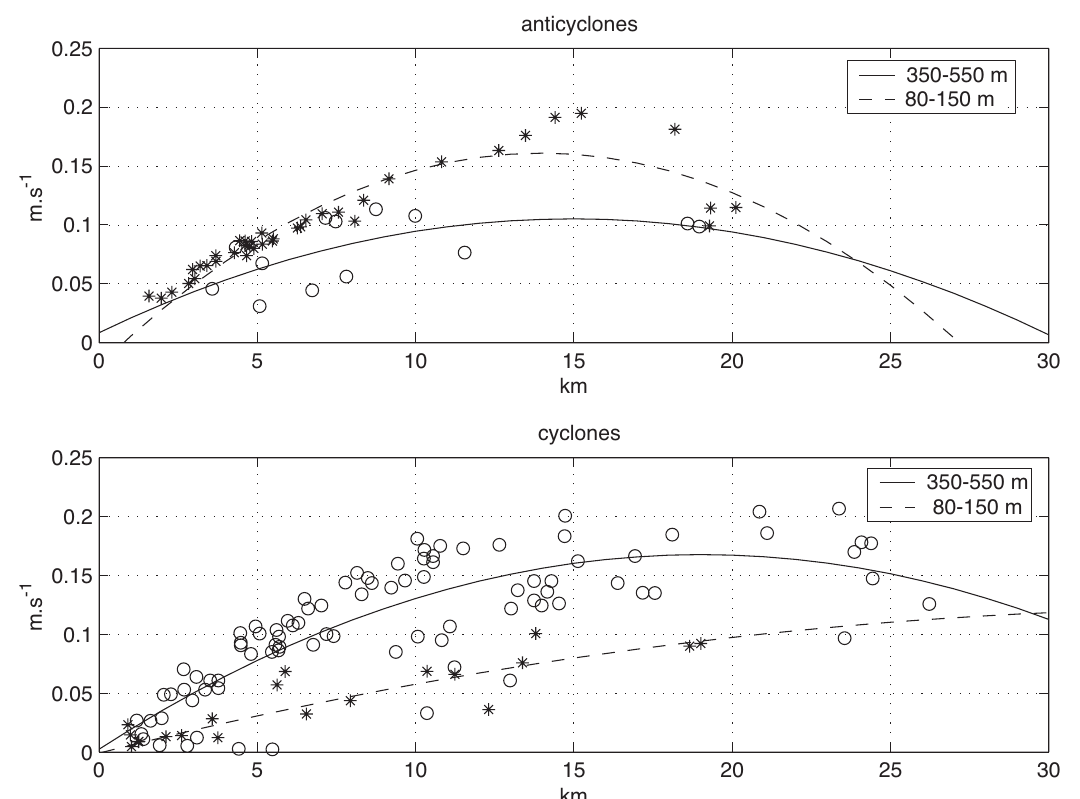
F IG . 9. – Azimuthal velocity (m/s) against distance from the eddy centre (km), for anticyclones (upper panel) and cyclones (lower panel) sam- pled in this study. Circles (o) stand for data from floats at the 450 m level and star (*) for data from Surdrifts at the 80-150 m depth level. A second-order polynomial fit is shown for the 80-150 m depth level (dashed-line) and the 450 m depth level (solid line)